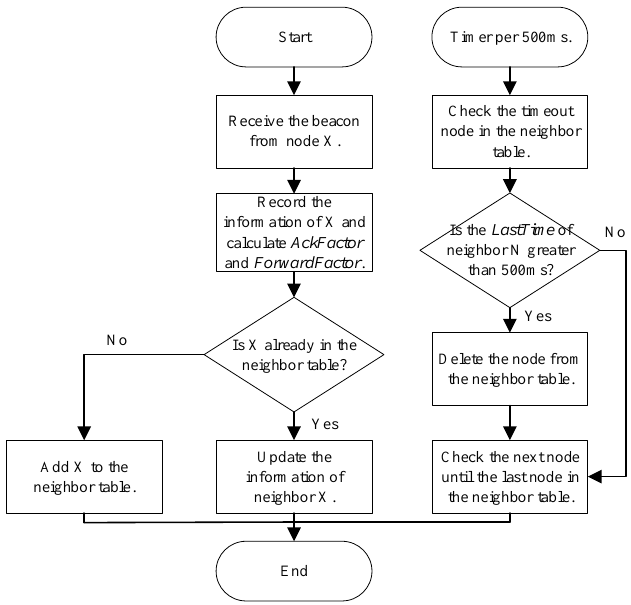
Table 3. The structure of the neighbor table.